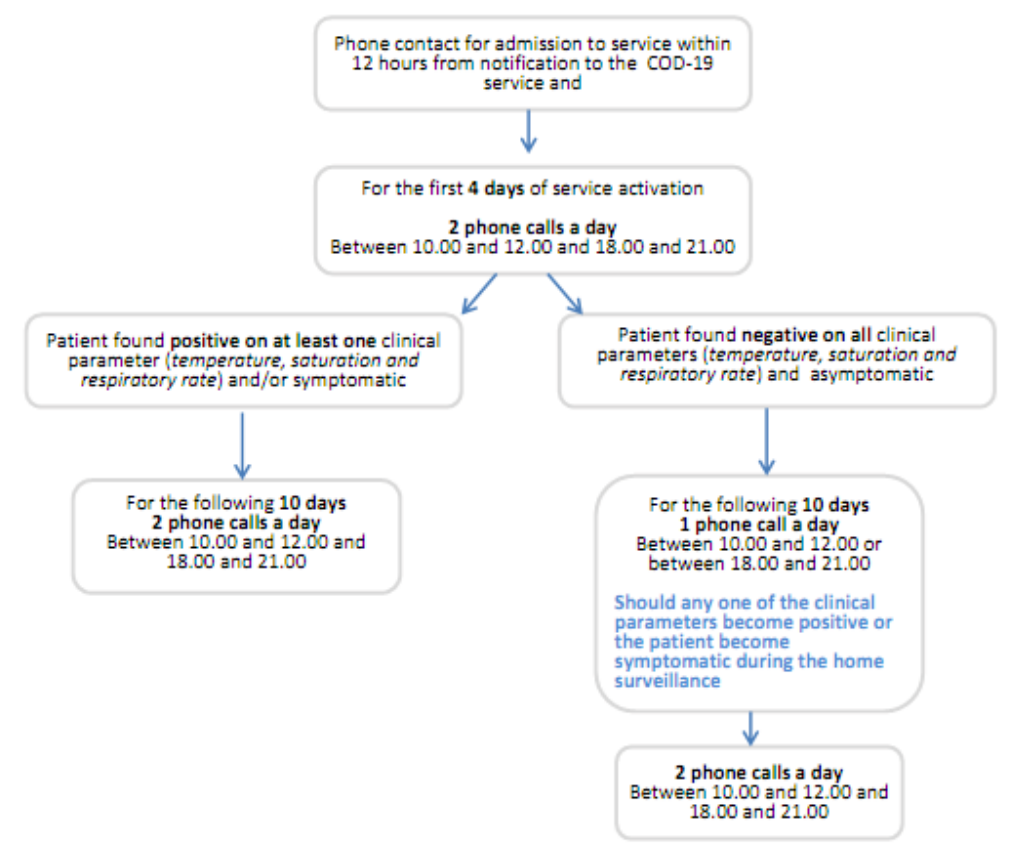
Figure 5. Algorithm for the management of active home surveillance over the 14 days.